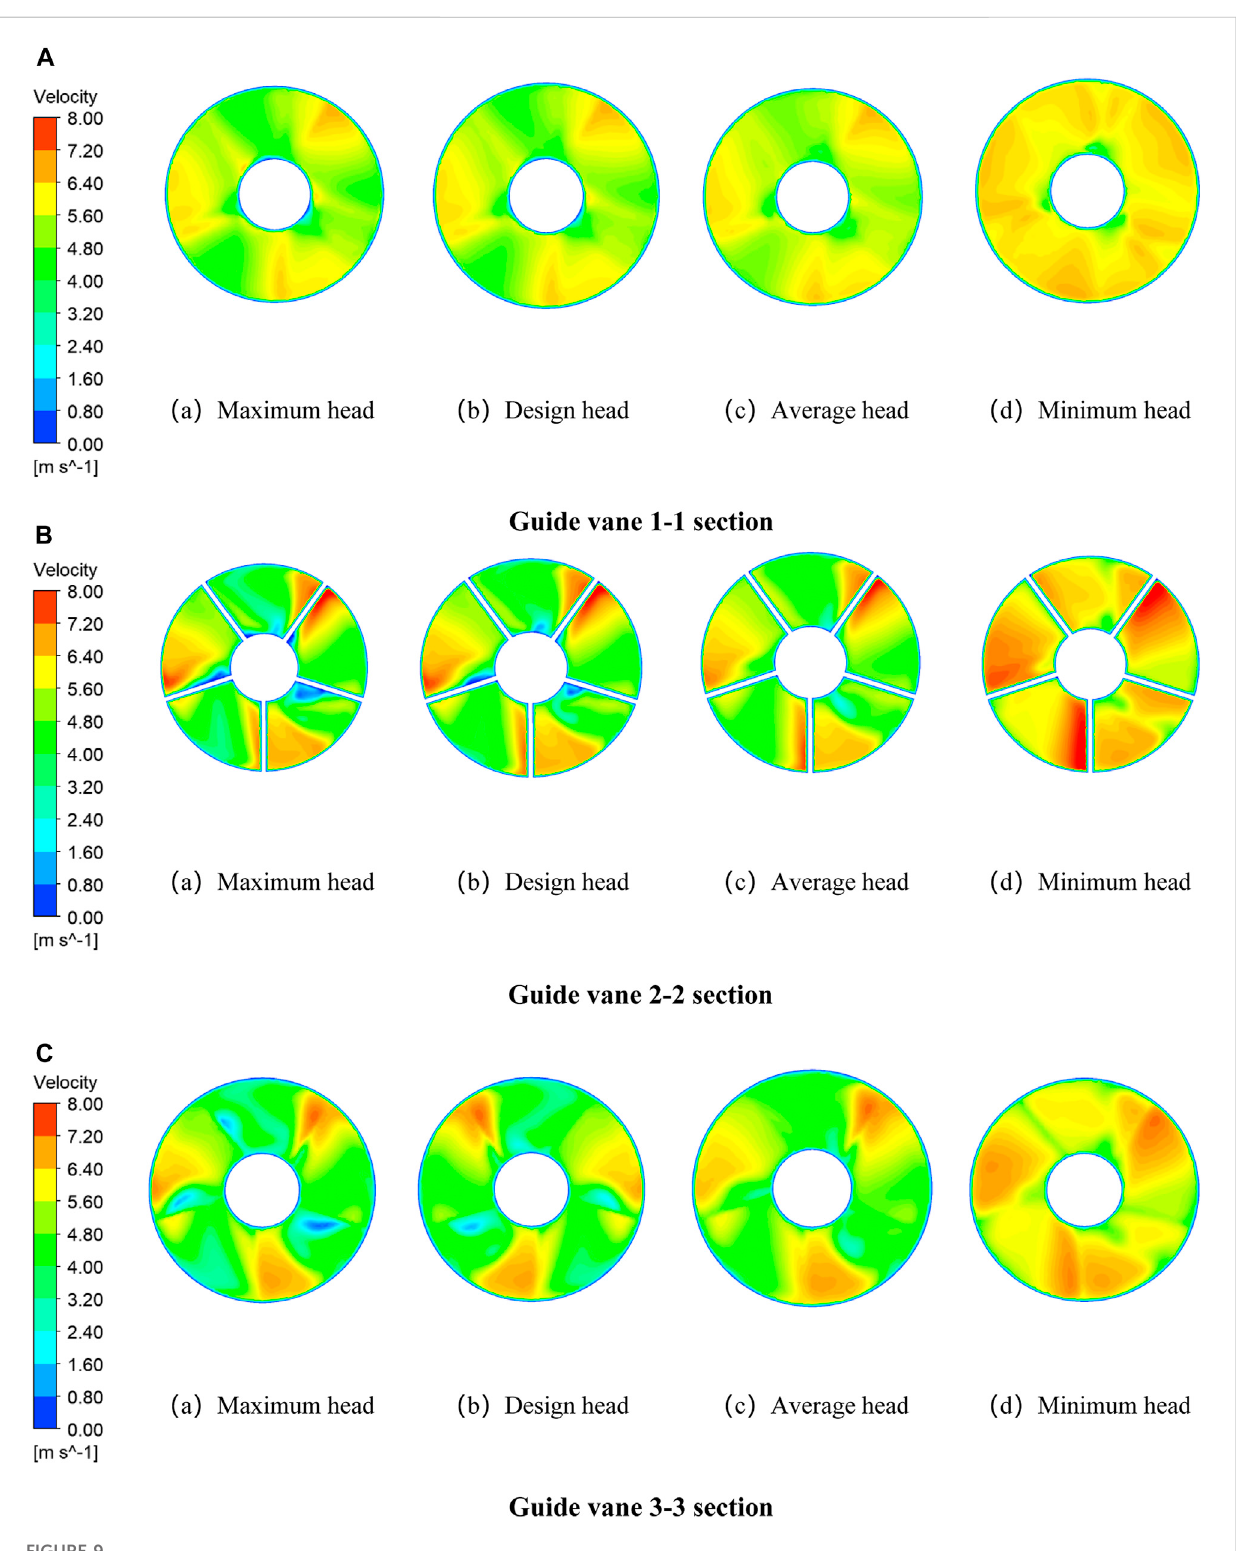
Guide vane domain velocity contour. (A) Guidevane 1-1section. (a) Maximum head. (b) Design head. (c)Average head. (d) Minimum head. (B) Guide vane 2-2 section. (a) Maximum head. (b) Design head. (c) Average head. (d) Minimum head. (C) Guide vane 3-3 section. (a) Maximum head. (b) Design head. (c) Average head. (d) Minimum